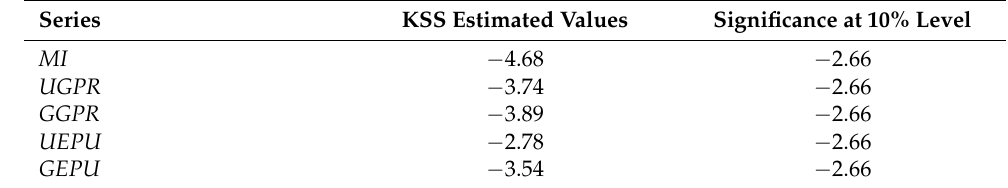
Figure 1. ( a – e ) show the trends of mineral import demand, USA’s geopolitical risks, global geopolitical risks, USA’s economic policy uncertainty, global economic policy uncertainty, respectively. Table 3. Results from the KSS unit-root